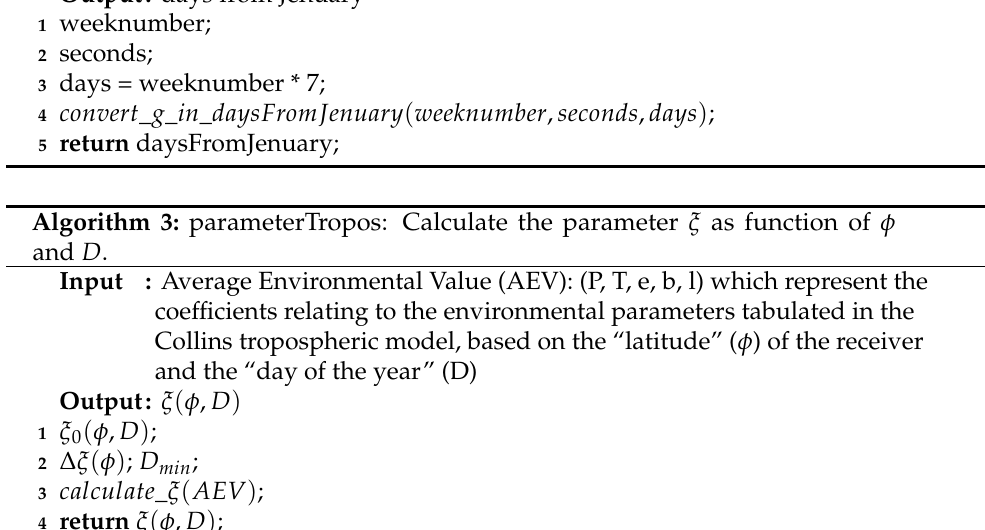
Algorithm 2: gpsTimeToDays: Converts from gpstime_t to the number of days from January.